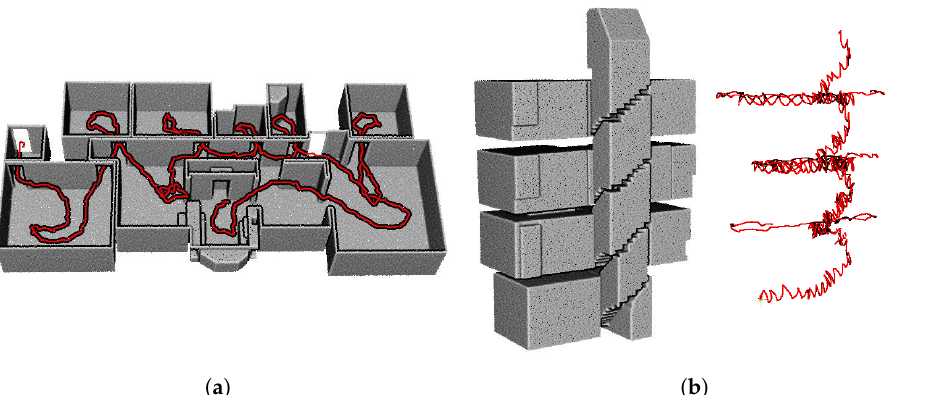
Figure 9. Structural points (grey) and the trajectory points (red) of ( a ) dataset A1 and ( b ) dataset C3. The trajectory is continuous through multiple rooms or multiple levels.